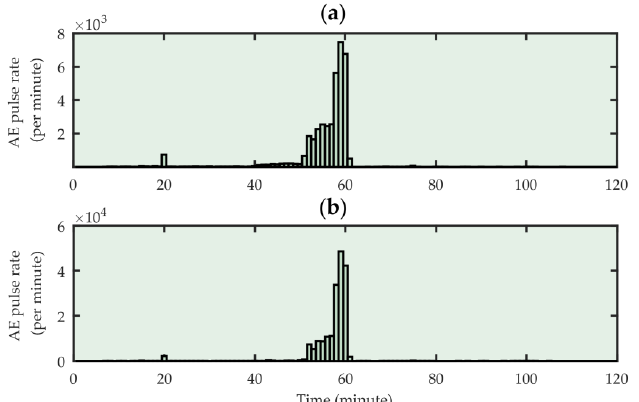
Figure 14. The number of AE pulses recorded during a 2-h partial discharge monitoring near the HV3 phase of a 10 MVA transformer by the reference PDtracker Portable system ( a ), and the tested low-cost PD monitoring system ( b ).